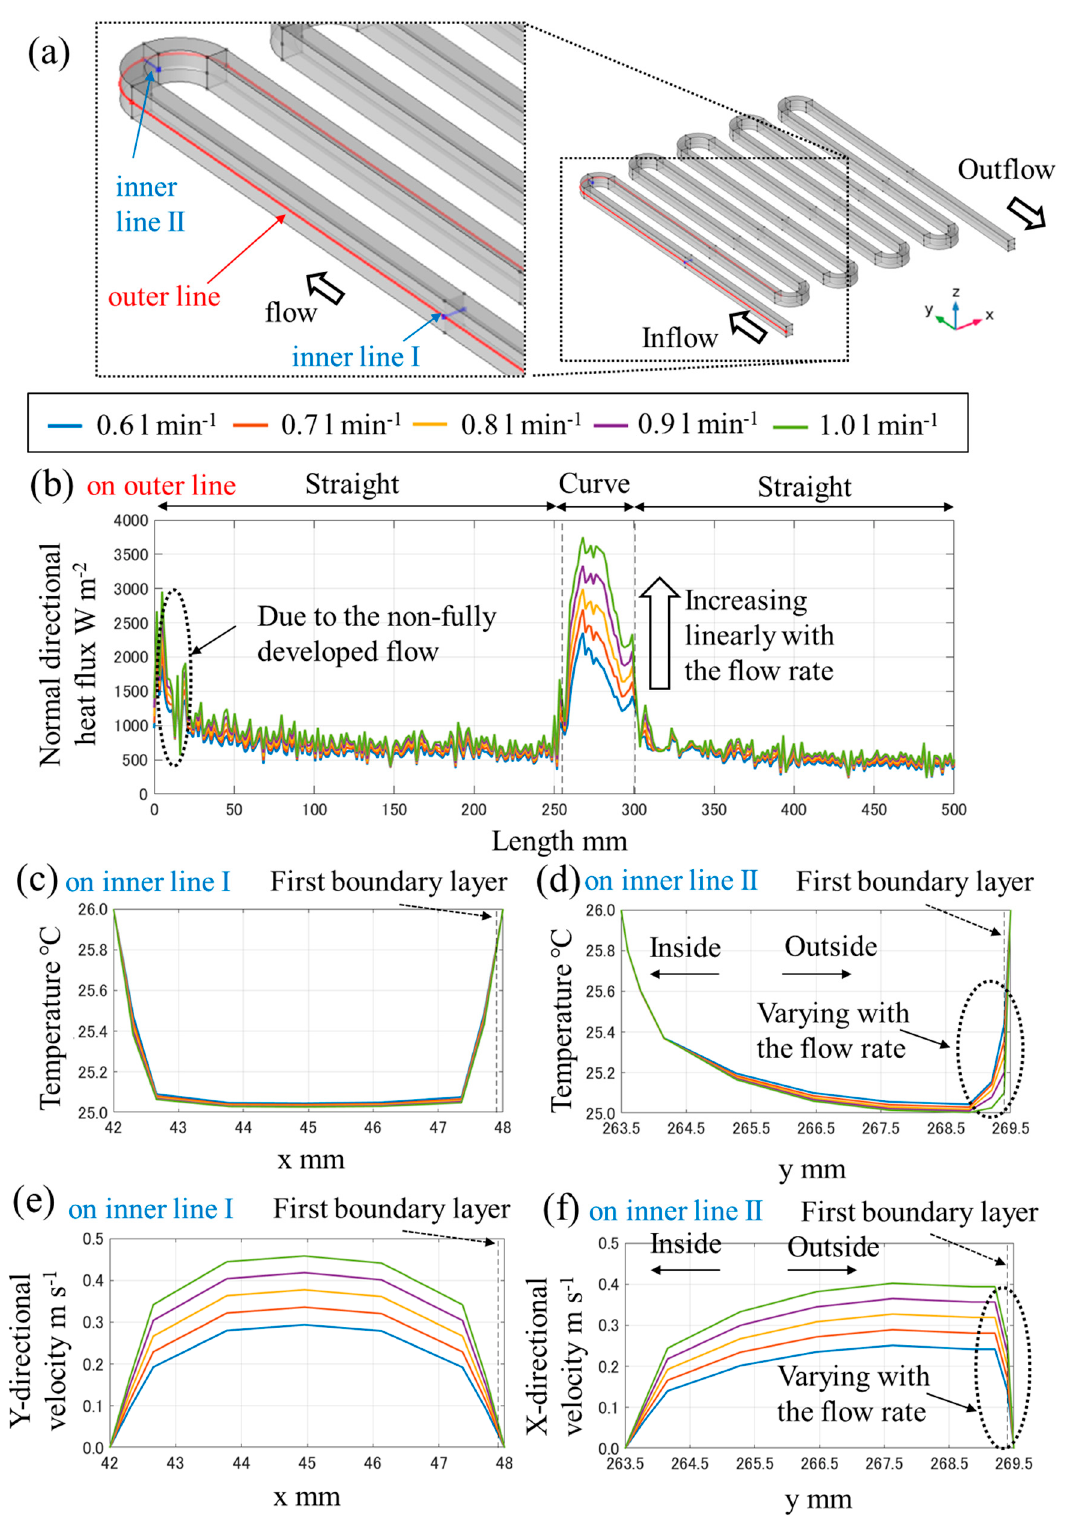
Figure A1. ( a ) The overview of the data output lines, and under the various flow rate ( b ) the normal directional heat flux profile on the outer line, the temperature profile on ( c ) the inner line I and ( d ) the inner line II, and the velocity profile on ( e ) the inner line I and ( f ) the inner line II.